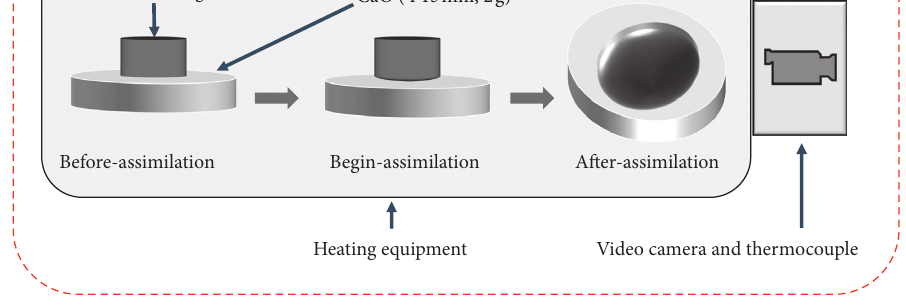
Figure 1: Diagrammatic chart of the assimilation characteristics experiment.